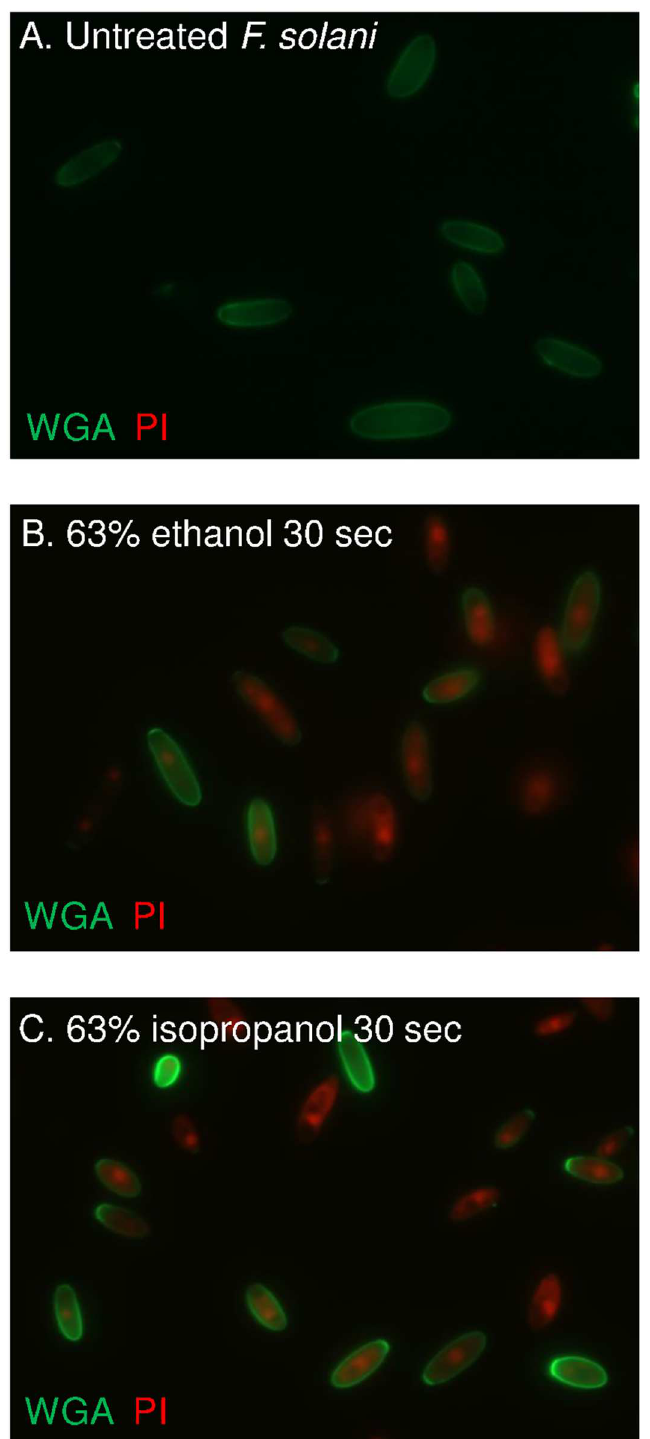
Fig 4. F . solani conidia are rapidly permeabilized and killed by ethanol and isopropanol. WGA (green) labelsglycoproteinsin the walls of both untreatedand alcohol-treated conidia(A to C). In contrast, PI (red) fails to penetratewalls of untreatedconidia(A), whilePI readily penetrate walls and plasma membraneand labelsnuclei of alcohol-treated conidiafor 30 sec (B and C). All images shot through the 100X objective.